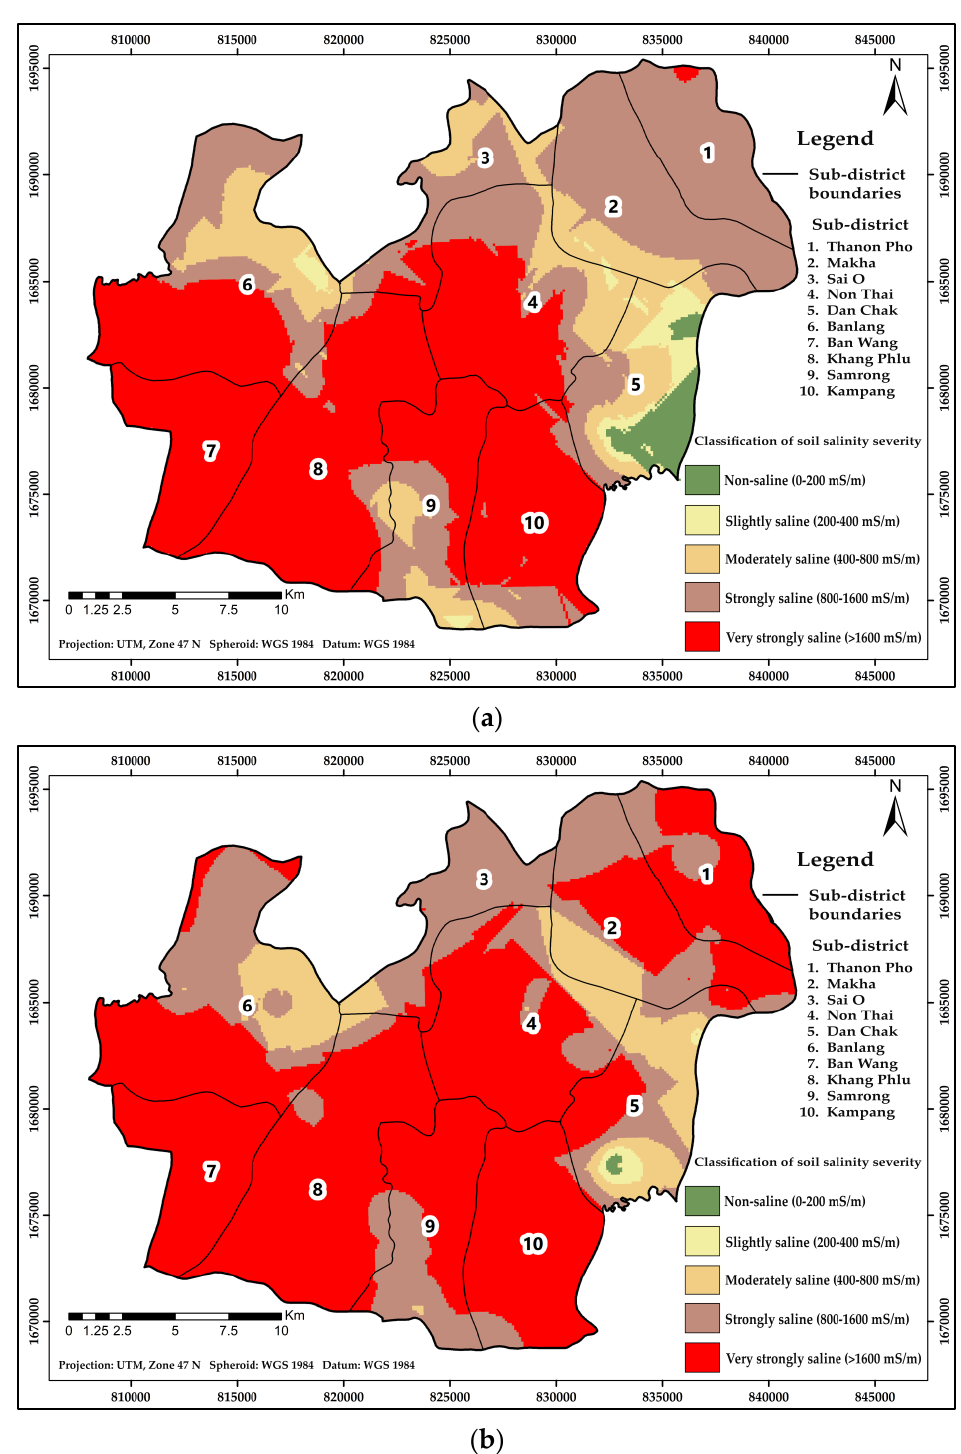
Figure 13. Spatial distribution map of soil salinity severity classification with a suitable method of two measuring modes in each sub-district: ( a ) HH and ( b ) VV. Table 18. Area of soil salinity severity classification with a suitable method in the two measuring modes by sub-district and district.